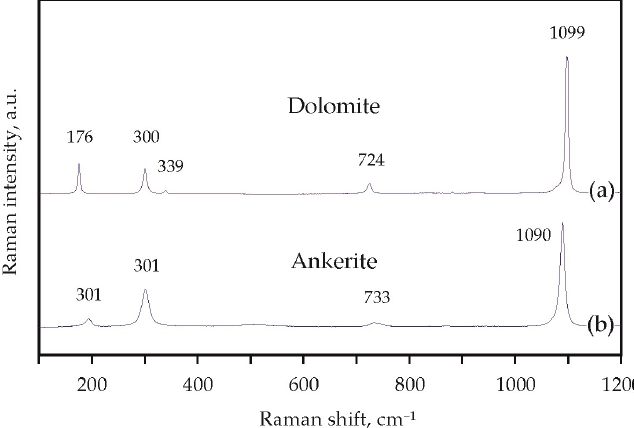
Figure 5. Raman spectra of starting materials—natural dolomite ( a ) and ankerite ( b ).